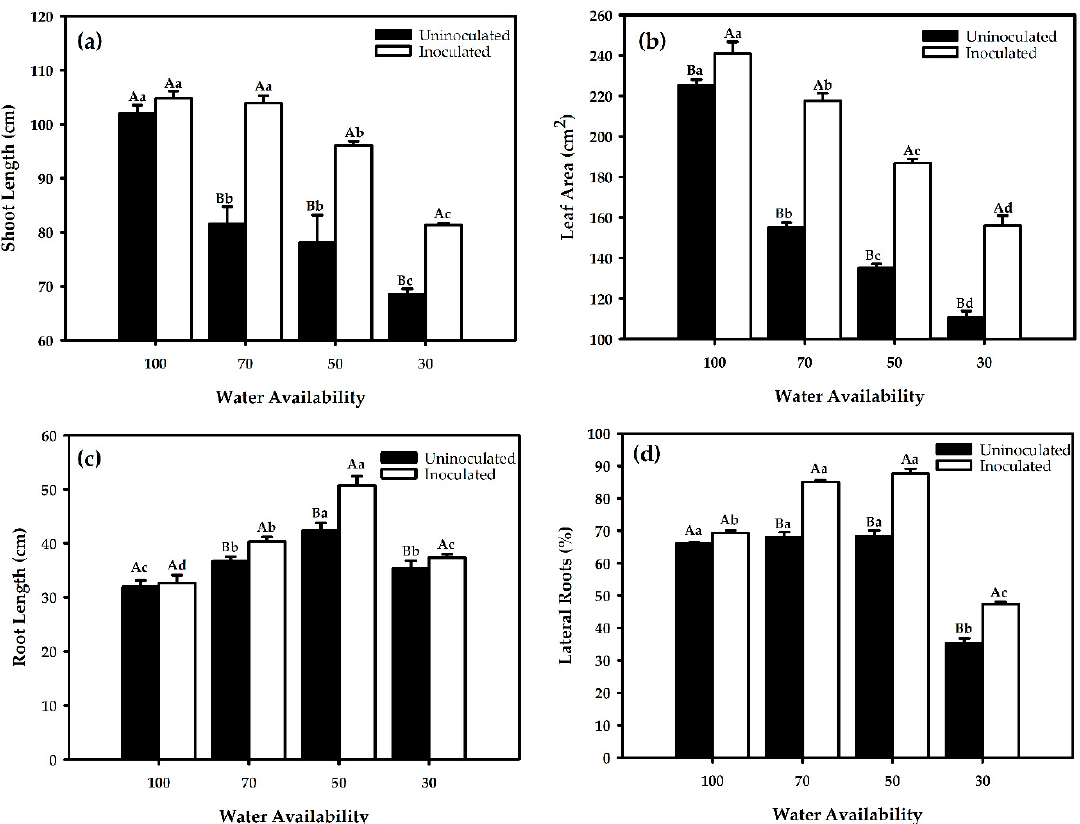
Figure 1. Shoot length ( a ), leaf area ( b ), root length ( c ), and lateral roots ( d ) in red rice under different water restriction and inoculation conditions. Averages followed by identical capital letters do not differ in the inoculation condition for each soil water treatment, and averages followed by identical lowercase letters do not differ in the percentage of soil water. Bars represent the standard error (n = 3).